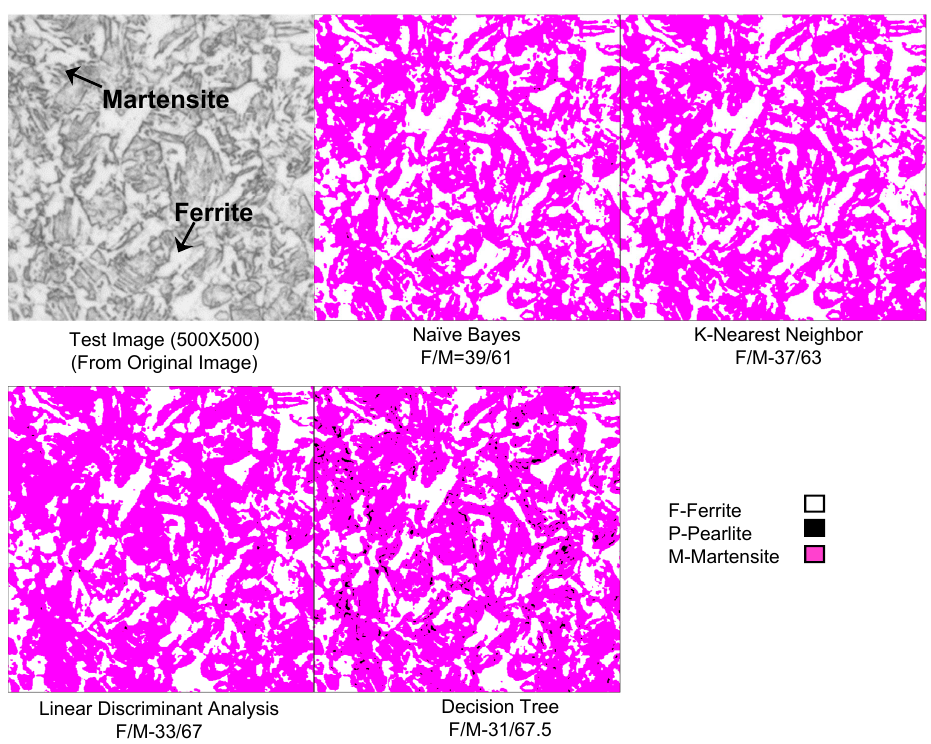
Figure 8. The microstructure of ASTM A36-900WC and machine learning-based metallurgical phase identification. All four classifiers predicted the phases accurately.